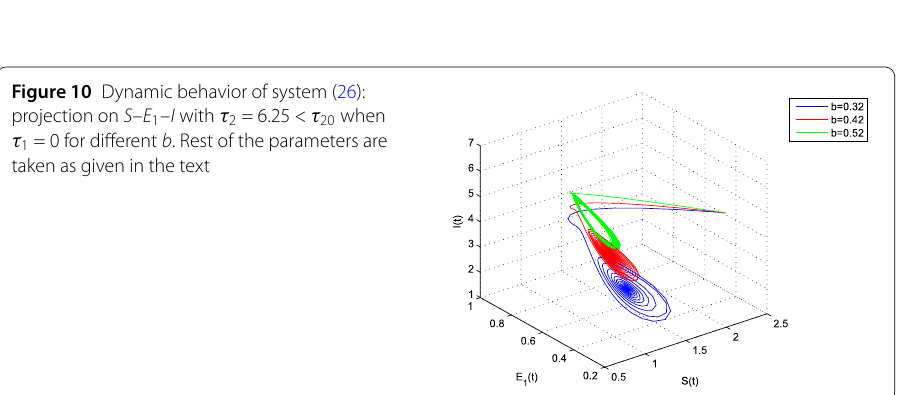
Figure 10 Dynamic behavior of system (26): projection on S – E 1 – I with τ 2 = 6.25 < τ 20 when τ 1 = 0 for different b . Rest of the parameters are taken as given in the text